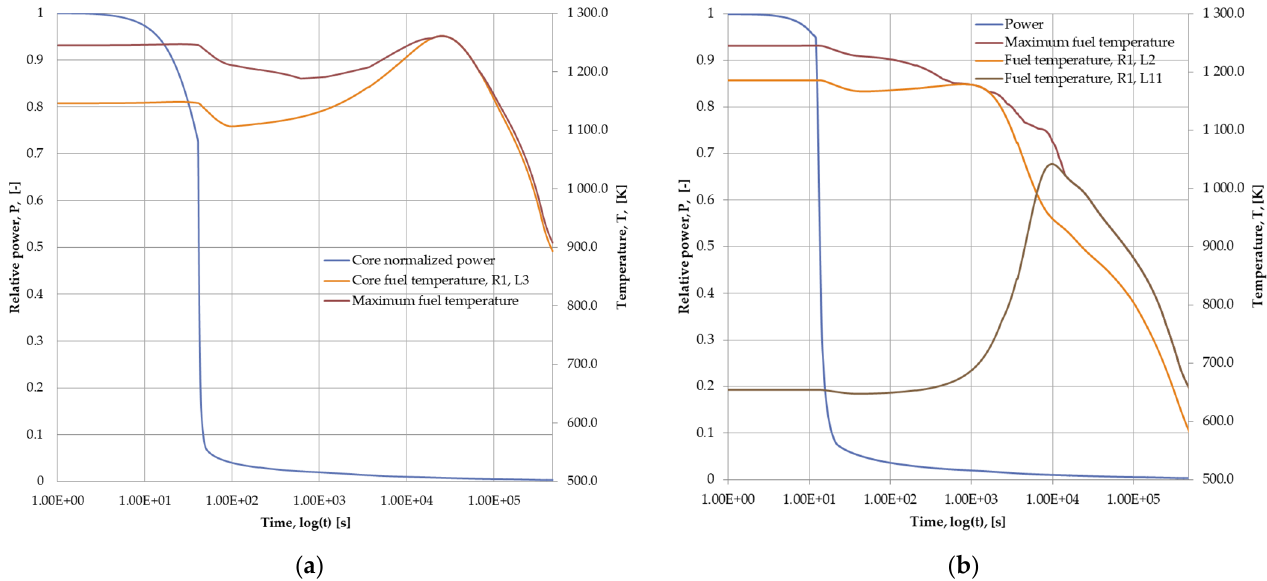
Figure 5. TRISO fuel release fraction of the core inventory for selected radionuclide groups. MEL- COR2.2 results for DLOFC accident with inventory at EOC core state.